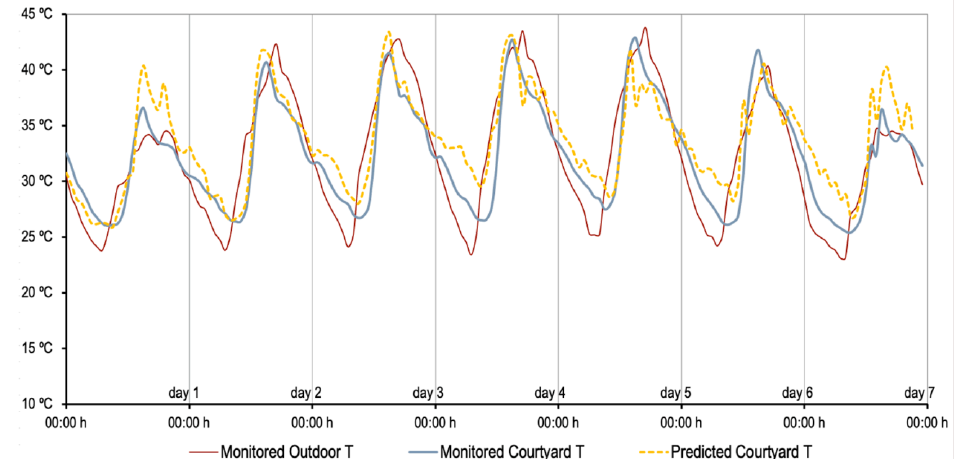
Figure 5. Example 3.0.2. Predicted temperature versus monitored and outdoor temperatures inside an ARI.1 courtyard.